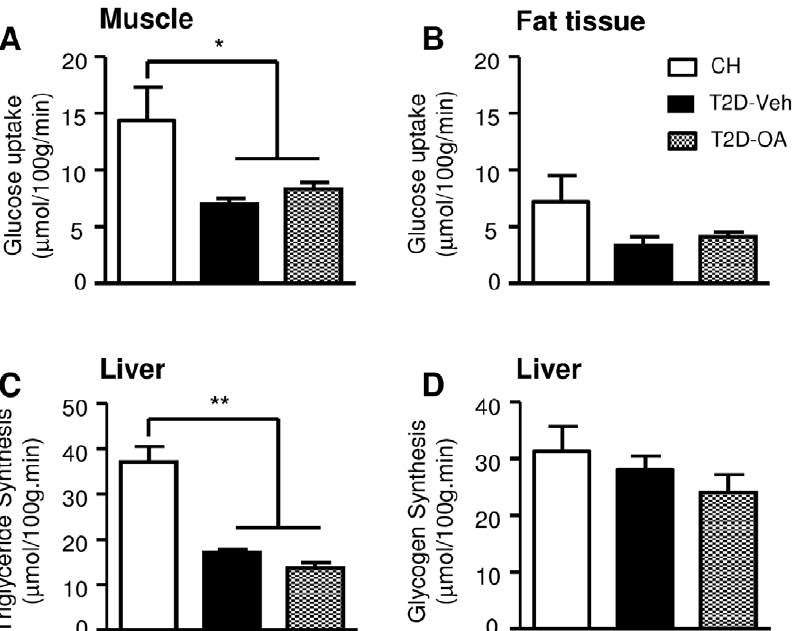
Figure 7. Changes in glucose flux into muscle, adipose tissue and liver 4 weeks after the removal of OA from the diet. An ipGTT (1 g/ kg, ip) using 2-deoxy-D-[1,2- 3 H] glucose and D-[ 14 C] glucose was performed 4 weeks after the cessation of OA treatment. At the end of the 40-min ipGTT, tissue samples were freeze-clamped immediately for the measurement of glucose uptake in quadriceps muscle ( A ) and epididymal fat ( B ), as well as the glucose incorporation into lipid ( C ) and glycogen ( D ) in the liver. * p , 0.05, ** p , 0.01 vs. CH, n=6–12 per group.